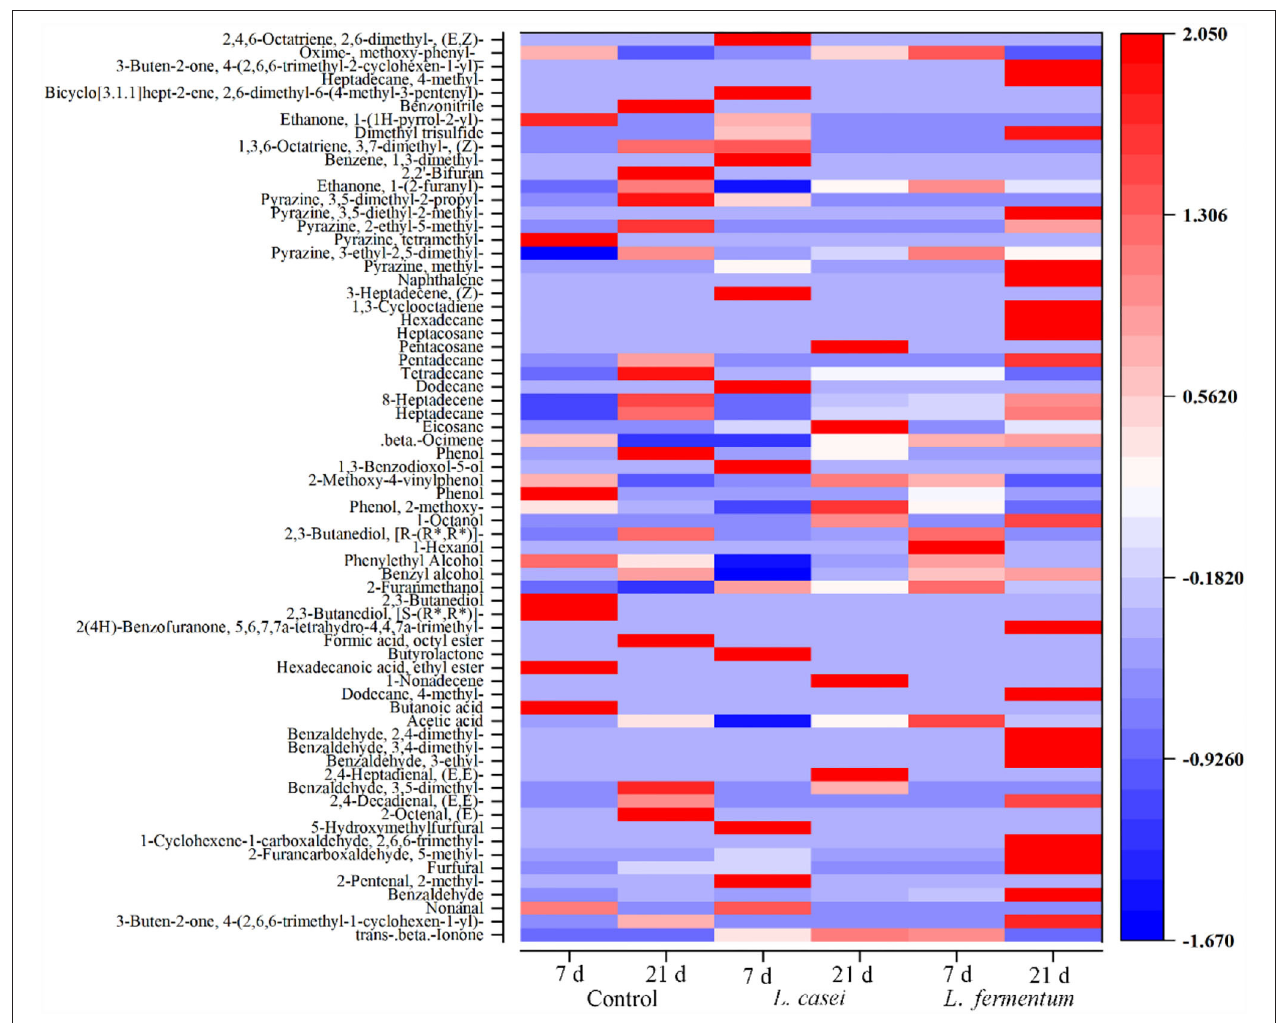
FIGURE 3 | Heat map of volatile substances of P. yezoensis sauces.